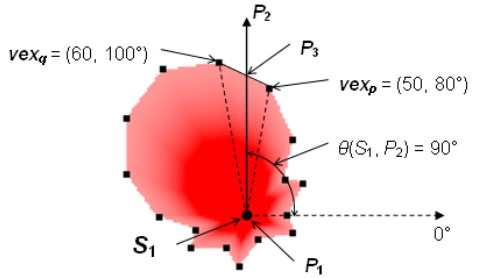
, P ) under the polygon n i